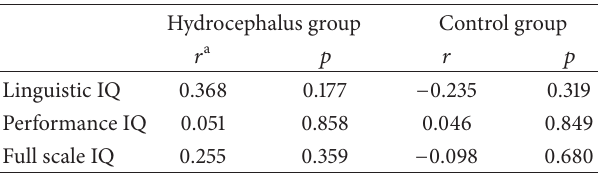
Table 4: Relationship between mean cortical thickness of the left middle temporal and IQ.